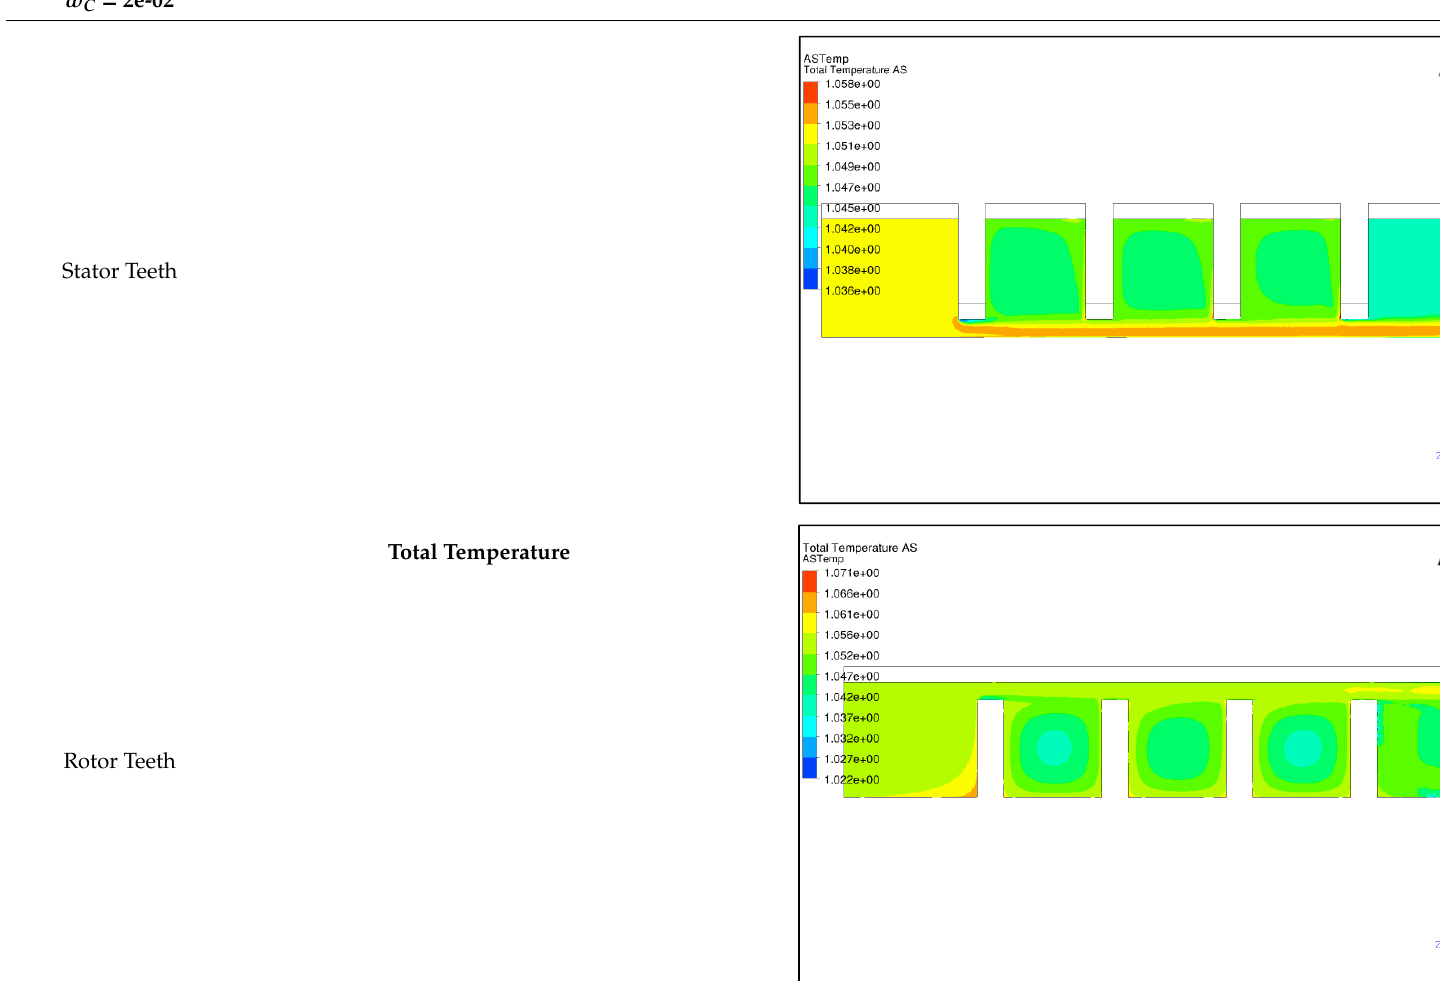
Table A3. Total temperature fields.